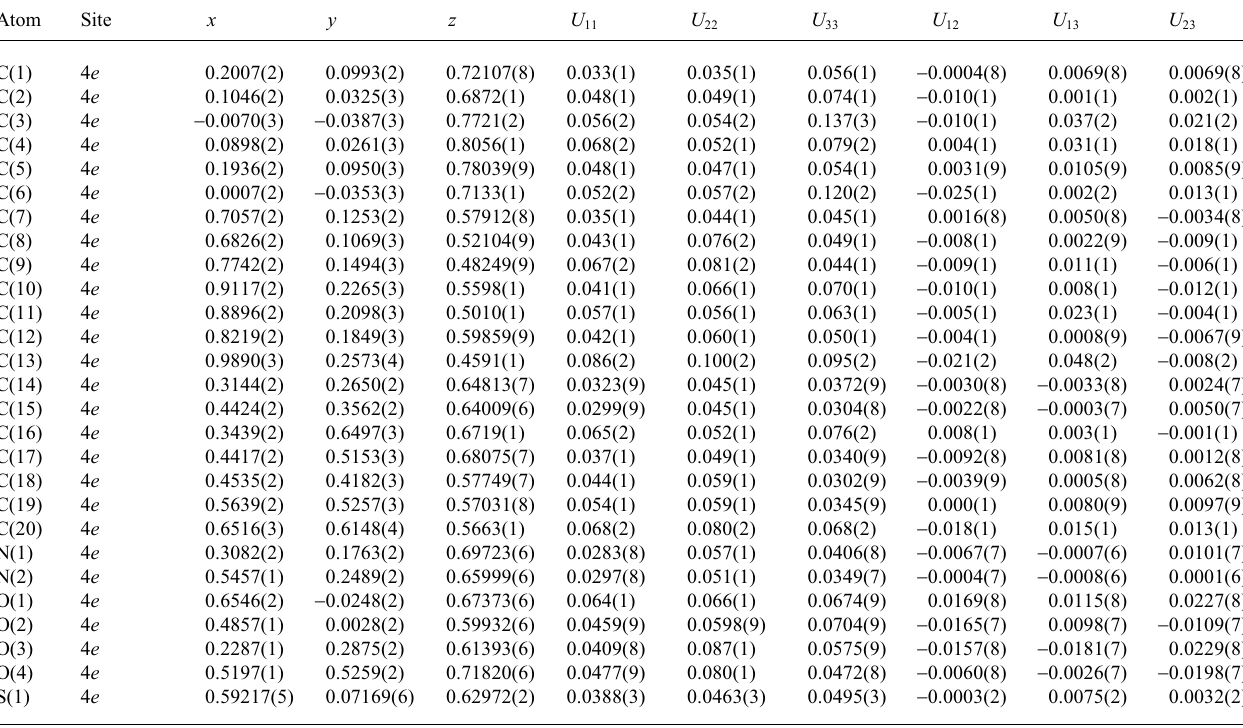
Table 3. Atomic coordinates and displacement parameters (in Å 2